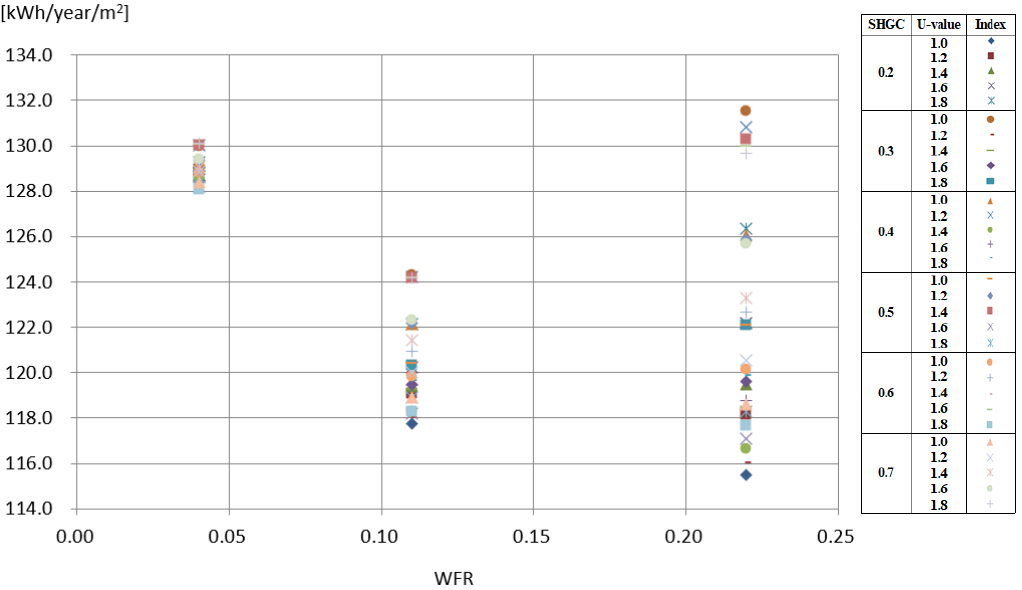
Figure 10. Energy demands per area according to the WFR and window properties.